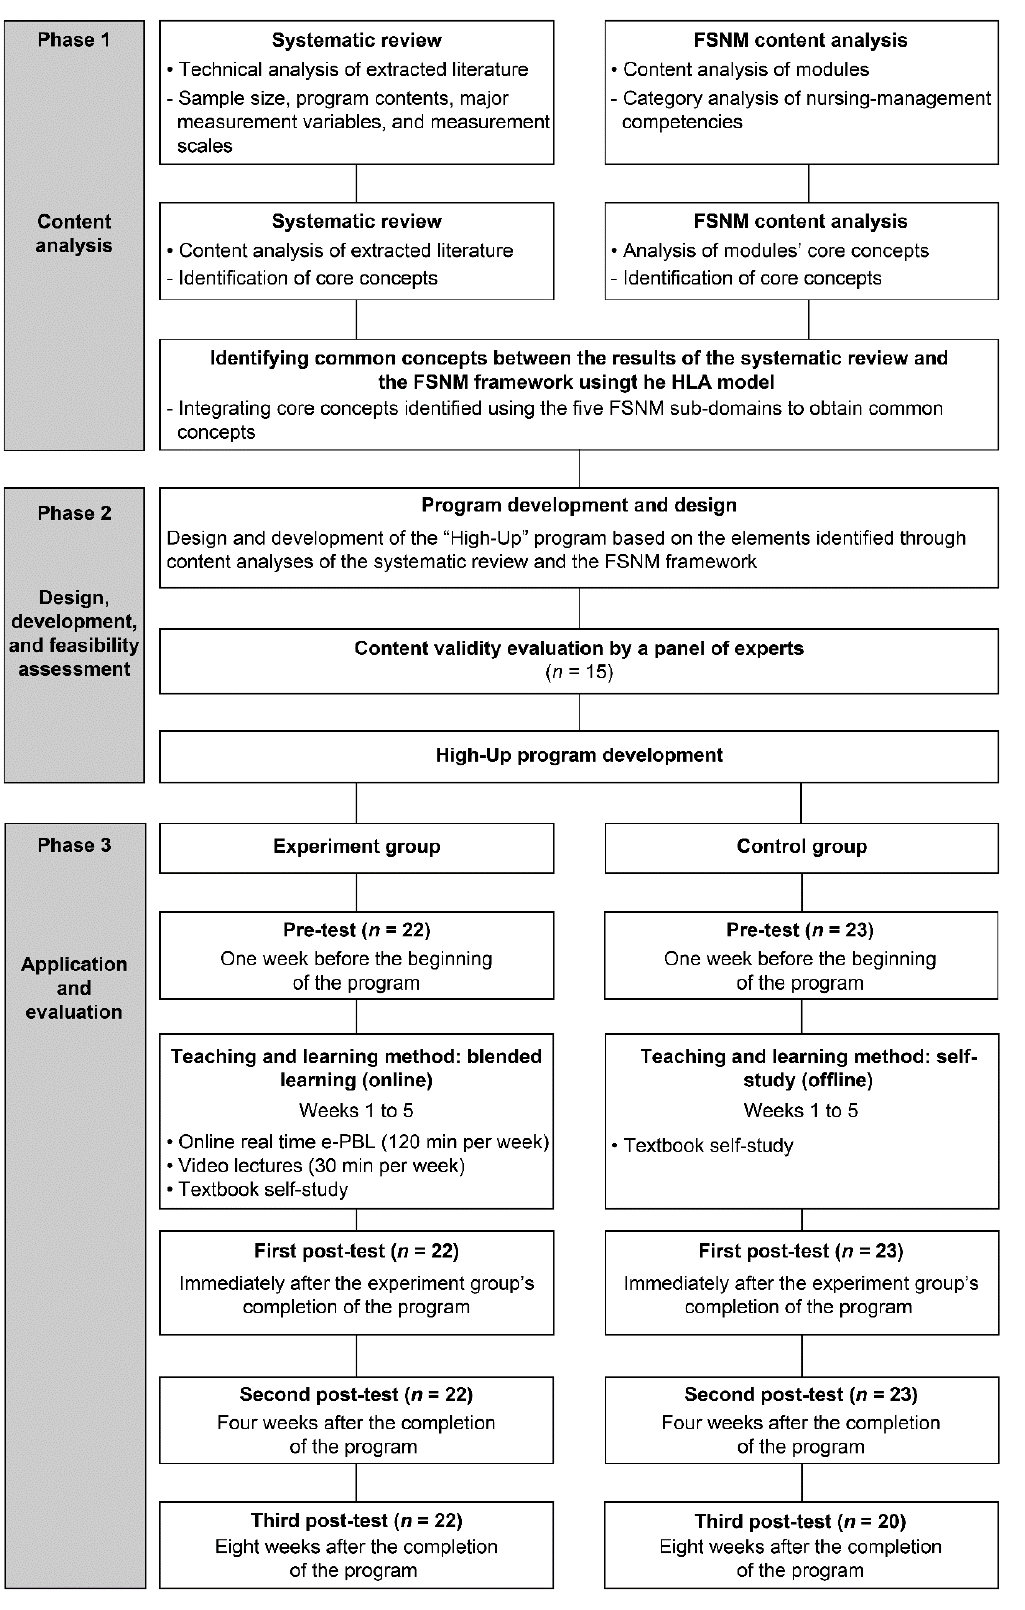
Figure 1. Chart outlining the development process for the “High - Up” program and the testing of its effects. FSNM: Fundamental Skills for Nurse Managers; HLA: Healthcare Leadership Alliance; PBL: problem-based learning.